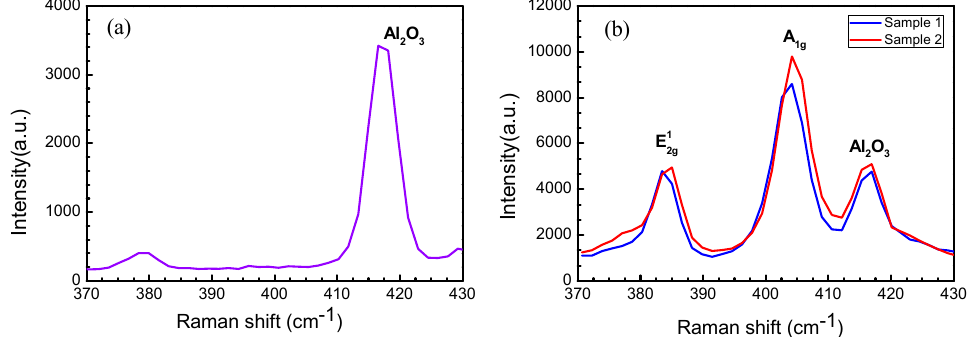
Figure 7. Raman spectra. ( a ) Clean sapphire substrate and ( b ) single-layer triangular MoS 2 samples deposited on the substrate. Sample 1: the temperature in the high temperature zone is 1073 K; Sample 2: the temperature in the high temperature zone is 1098 K.